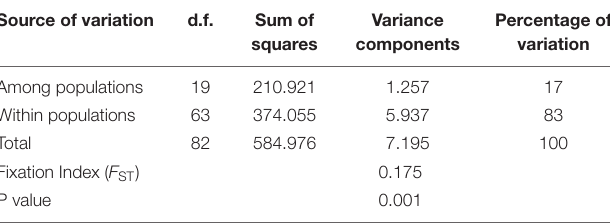
TABLE 3 | Analysis of molecular variance (AMOVA) based on ITS sequences of the Hemileia vastatrix populations. Source of variation